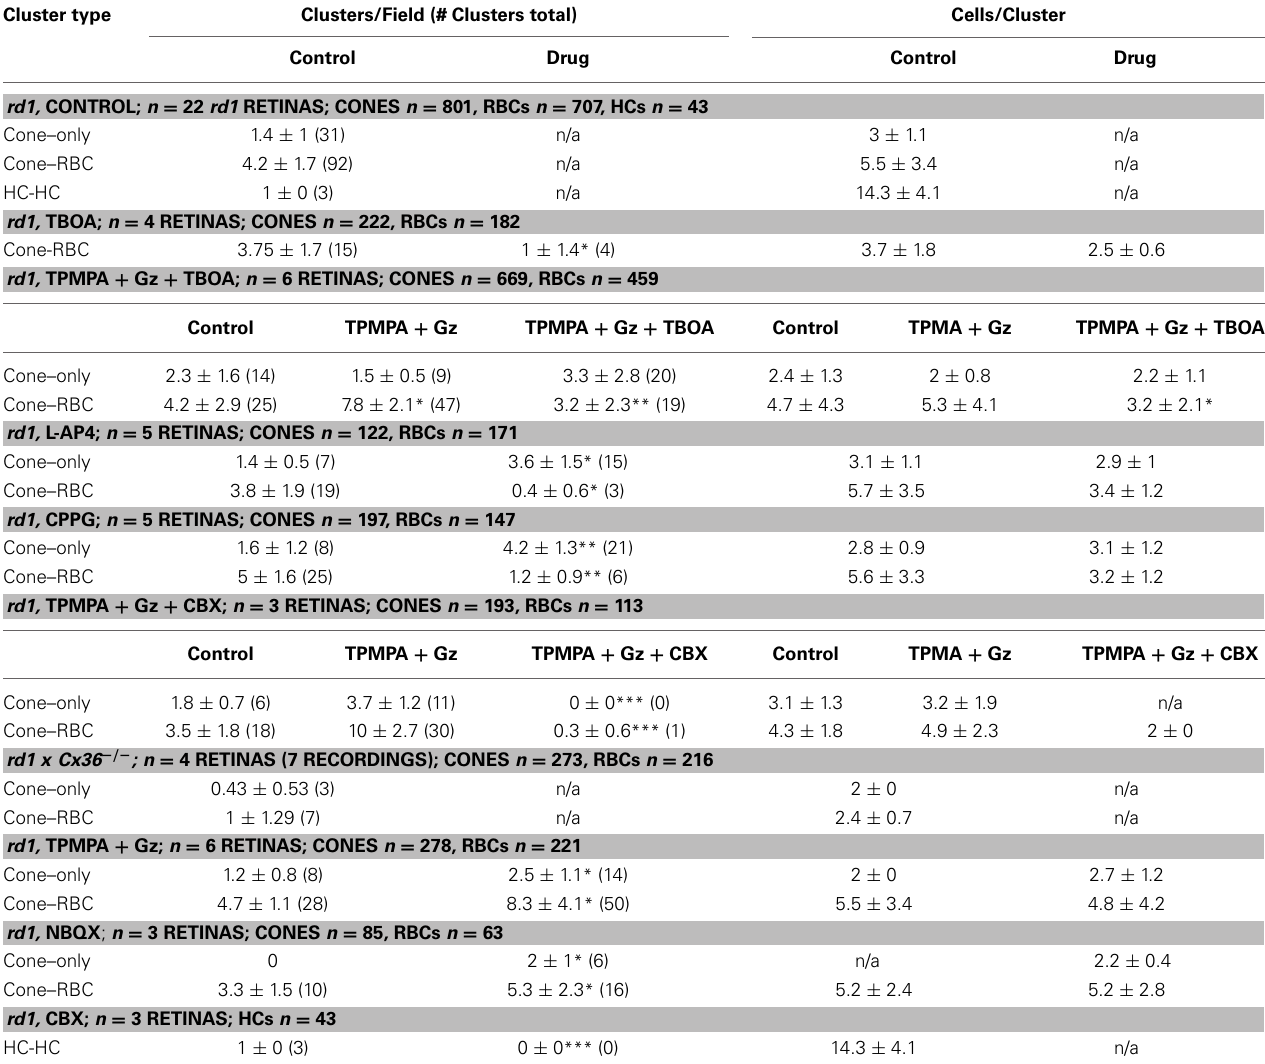
Table showing cluster activity (clusters/field and cells/cluster) for cone-only clusters, cone-RBC clusters and HC-HC clusters for control and drug condition. Statistical significance is indicated as * p < 0.05, ** p < 0.01, and *** < 0.001 (control vs. drug condition). Gz, Gabazine; CBX, carbenoxolone.